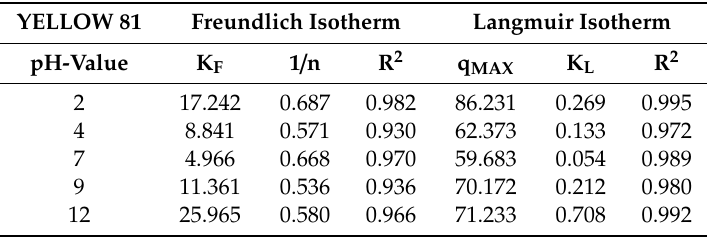
Table 6. Return of adsorption isotherm data for Reactive Yellow 81.